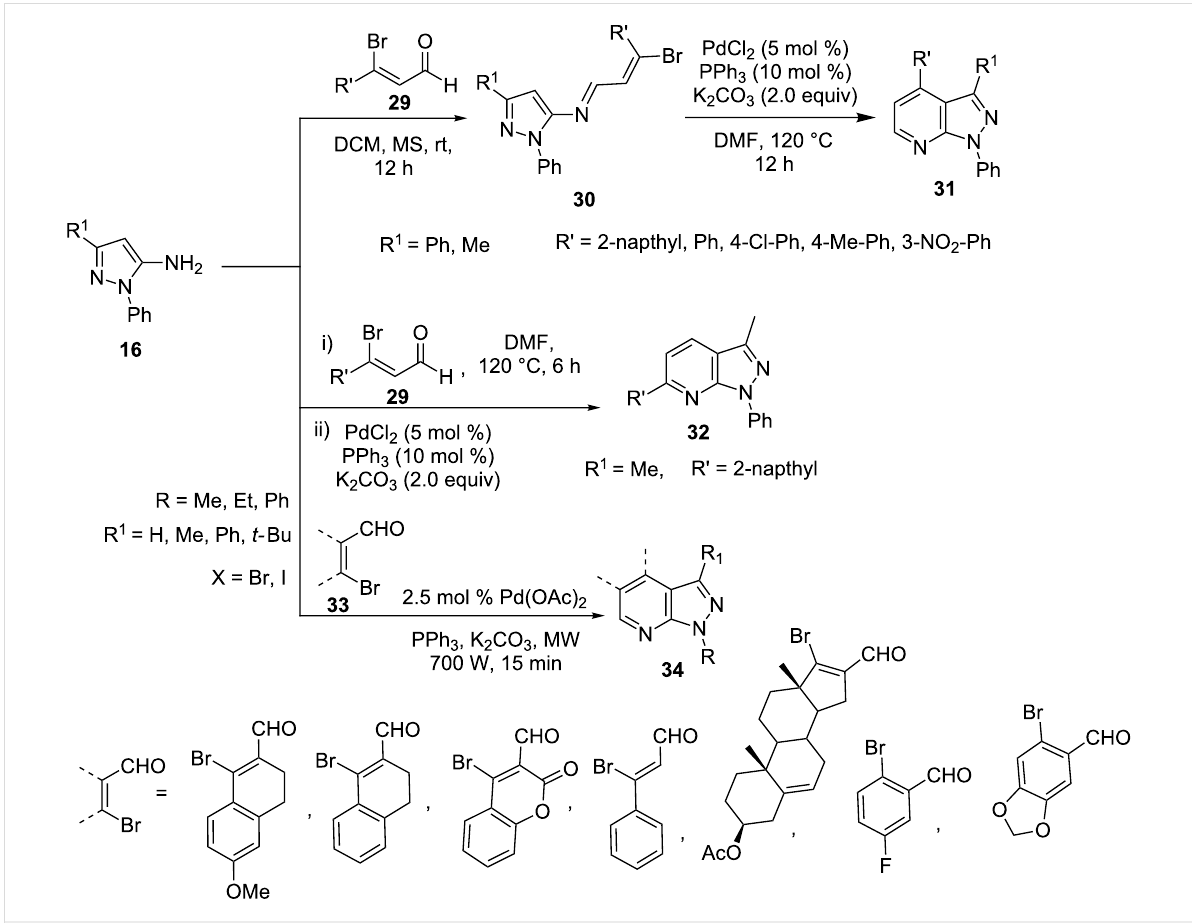
cytotoxic activity against cervical HeLa and prostate DU 205 cancer cell